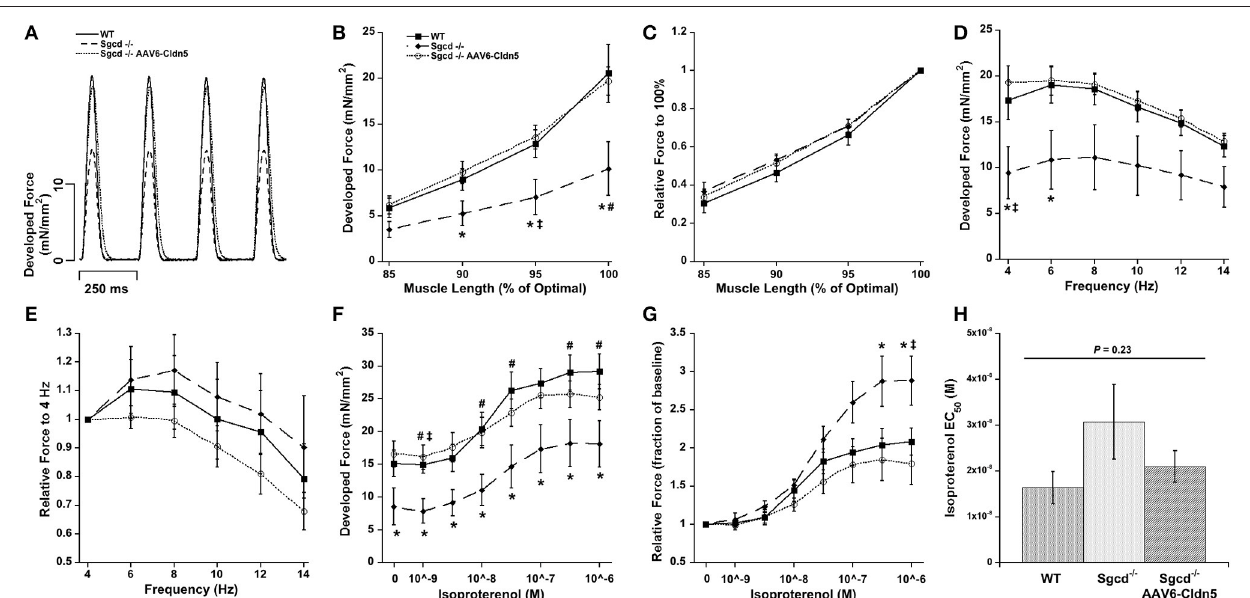
FIGURE 1 | Contractility of isolated cardiac trabeculae from 20 week-old wild-type (WT), Sgcd − / − , and Sgcd − / − mice treated with AAV6-Cldn5 ( Sgcd − / − AAV6-Cldn5). (A) Tracings of cardiac trabeculae contracting at stimulation frequency of 4 Hz. (B) Sgcd − / − cardiac muscles had significantly lower forces than the two other groups at several muscle lengths. (C) Normalized length-tension relationship shows that increasing muscle length increases developed forces to a similar relative extent in all three groups. (D) Force-frequency relationship was similar and flat-to-negative in all three groups. (E) Normalized relationship between force and frequency is preserved across all three groups. (F) Sgcd − / − muscles had overall lower forces at all isoproterenol concentrations as compared to the two other groups. (G) Isoproterenol enhanced developed forces in all three groups. (H) The isoproterenol EC 50 was not statistically different across the three groups. *Signifies P < 0.05 among the three groups as assessed with ANOVA. # , Signify P < 0.05 Sgcd − / − vs. WT and Sgcd − / − vs. Sgcd − / − AAV6-Cldn5, as assessed with Bonferroni post-hoc , respectively. The numbers of mice of each group from which muscles were measured and included in the analysis were: WT ( n = 7, 3M, 4F); Sgcd − / − ( n = 7, 2M, 5F); Sgcd − / − AAV6-Cldn5 ( n = 6, 5M,